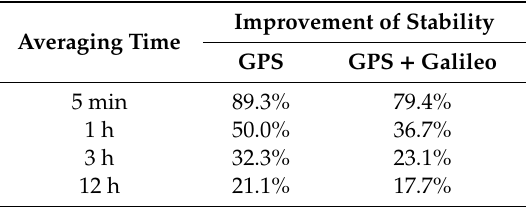
Table 1. The stability improvements when applying constraint model to global positioning system (GPS) precise point positioning (PPP) (black to the green line in Figures 7 and 8) and GPS + Galileo PPP (red to the light blue line in Figures 7 and 8), respectively.